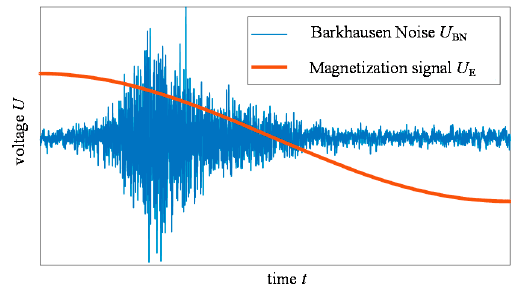
Figure 1. View of the exemplary Barkhausen noise and magnetization signals.